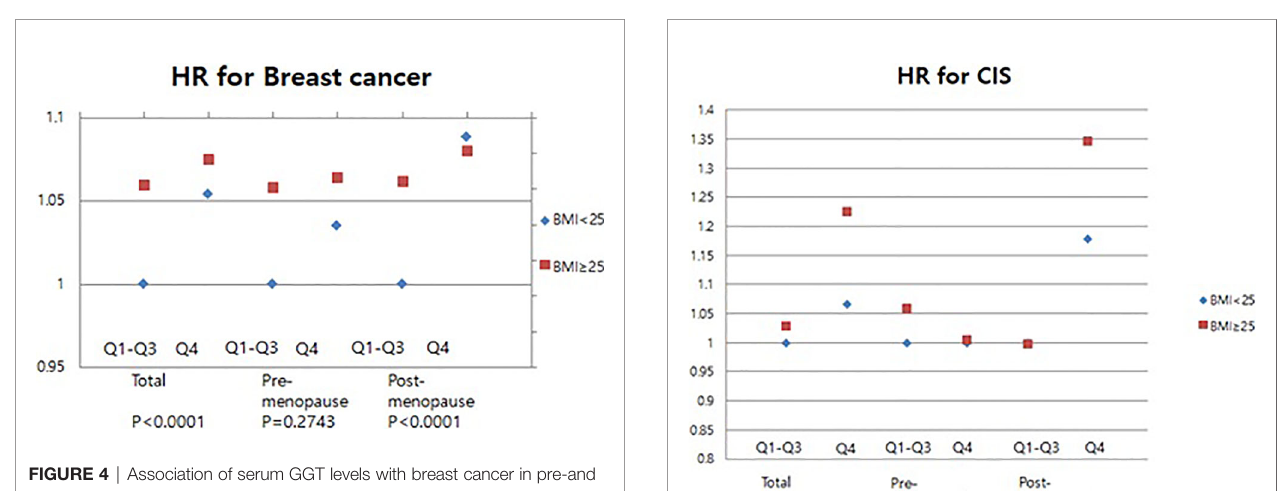
FIGURE 4 | Association of serum GGT levels with breast cancer in pre-and post-menopausal women by BMI.